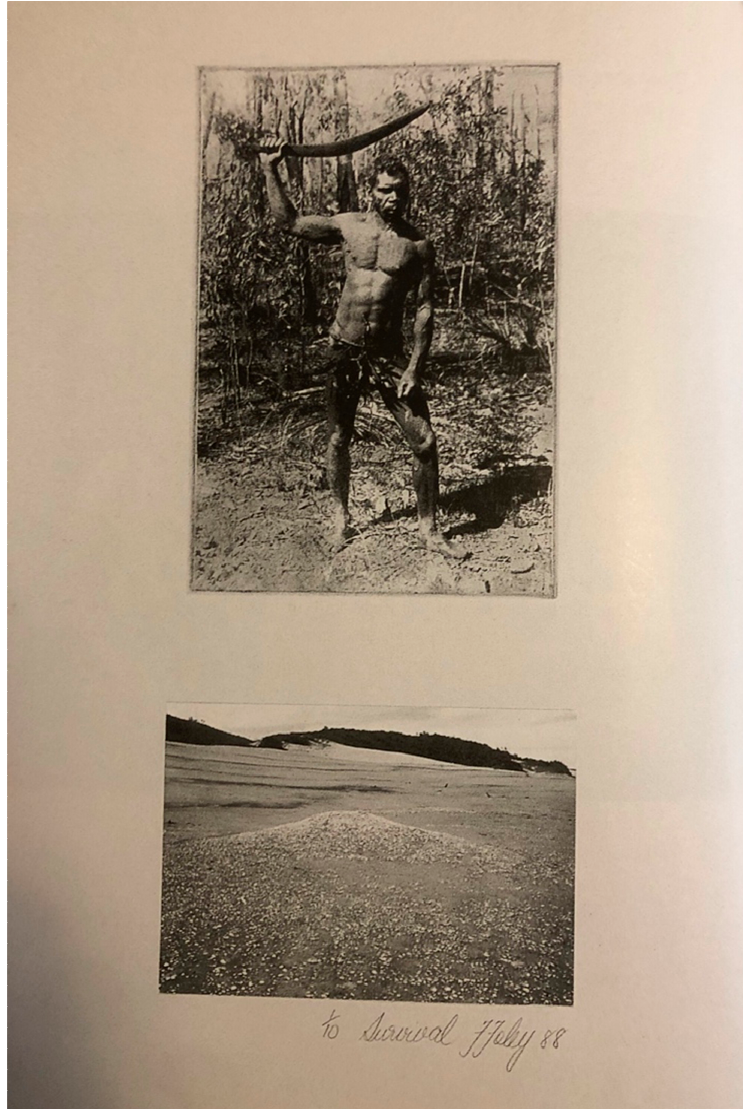
Figure 2. Fiona Foley’s Survival III, IV (1988) Photo etching and collage on brown paper. Edition 2 / 10. Two of four sheets: 56.5 × 38 cm (each). Courtesy of Queensland Art Gallery and Gallery of Modern Art, Brisbane, Australia.